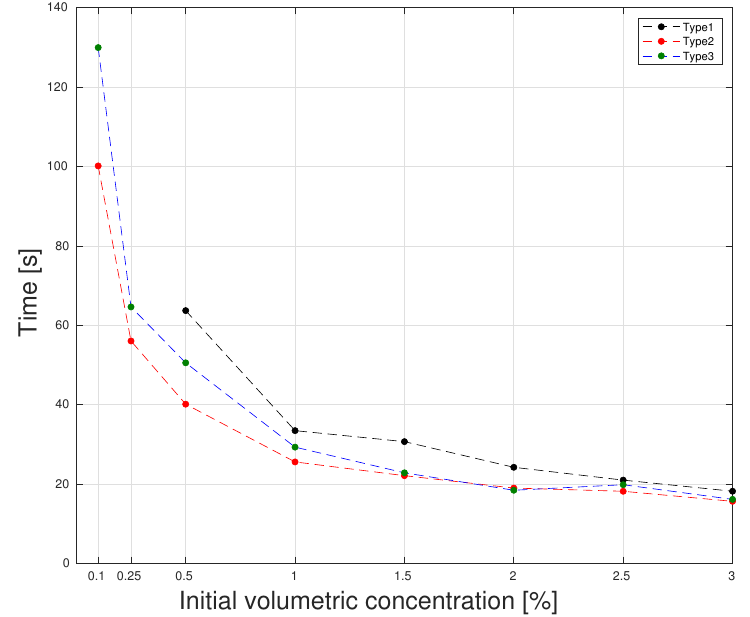
Figure 7. Time needed by the current to reach the end of the visualized region as a function of the initial